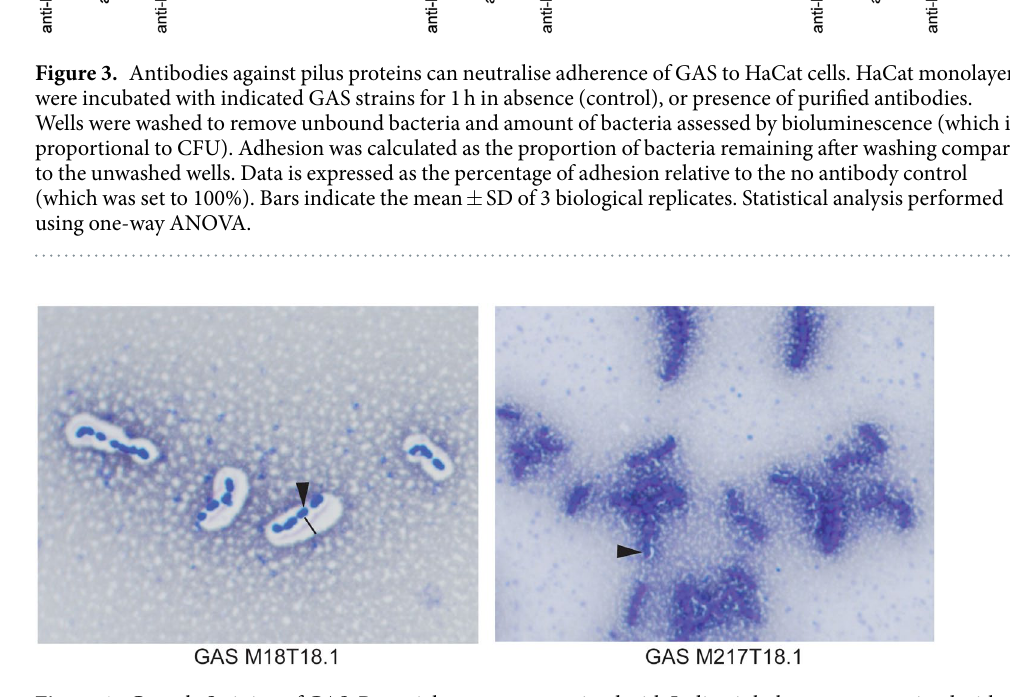
Figure 4. Capsule Staining of GAS. Bacterial smears were stained with Indian ink then counter-stained with crystal violet. Capsule is observed as a white halo surrounding GAS M18T18.1, but not GAS M217T18.1. Arrow points to an example of a bacterium, line indicates thickness of